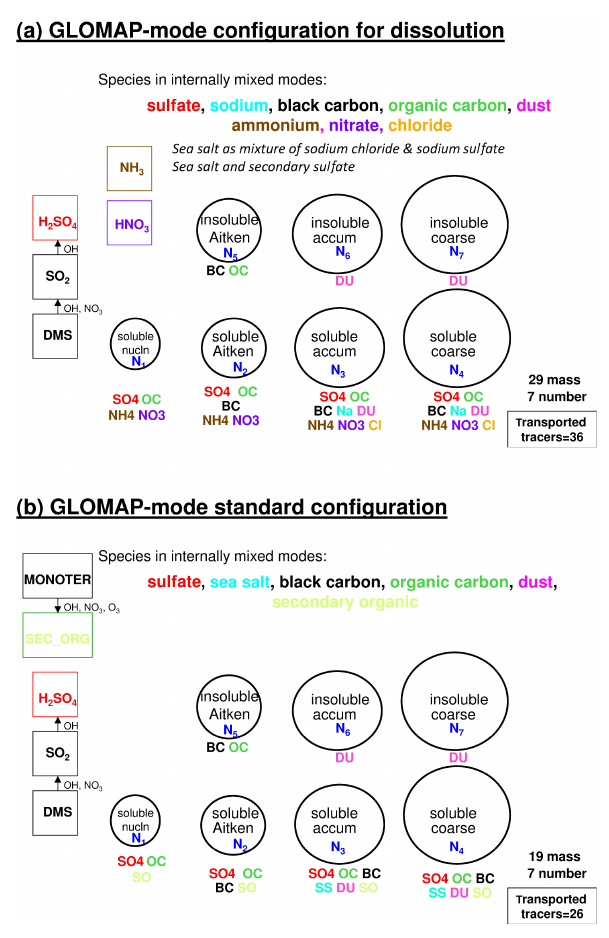
Figure 12. Diagram illustrating the species contained in each size mode for the HyDiS-1.0 extended configuration of GLOMAP- mode (top) compared to that for the standard GLOMAP-mode (bot- tom), as described in Mann et al. (2010).